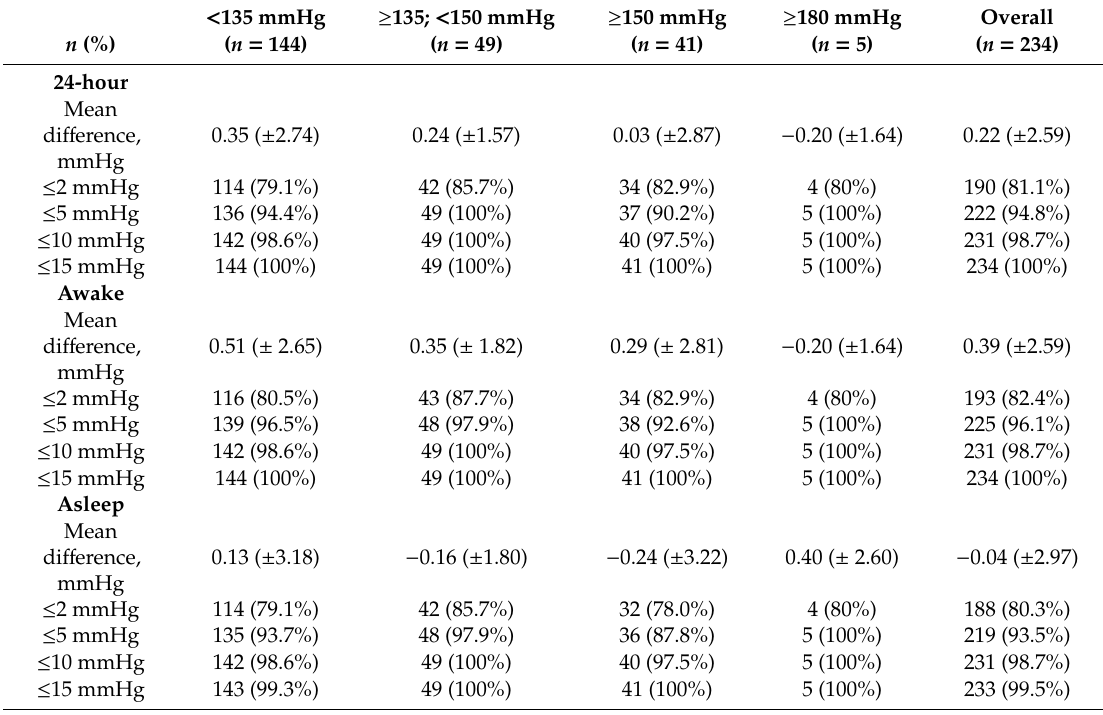
Table 6. Agreement between DominoBP and SchillerBP derived blood pressure data for mean systolic blood pressure values in di ff erent blood pressure categories, stratified by DominoBP mean systolic awake blood